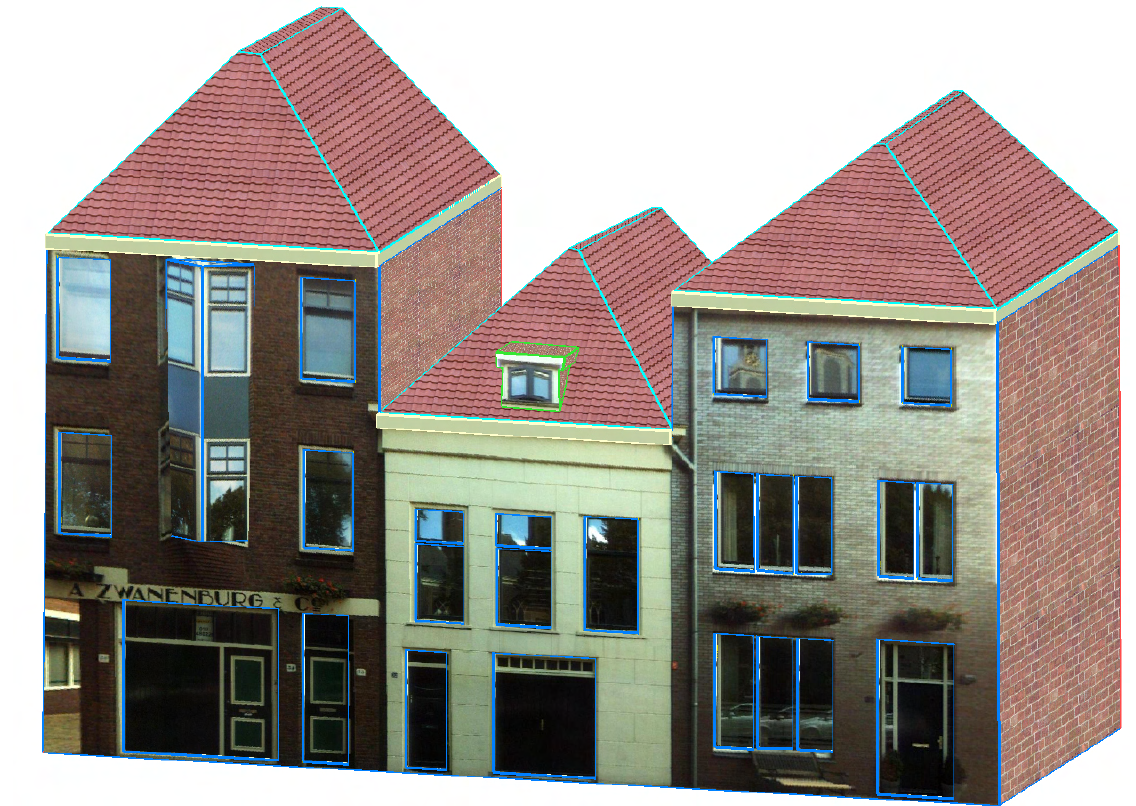
Figure 12. Reconstructed facade model of three joined